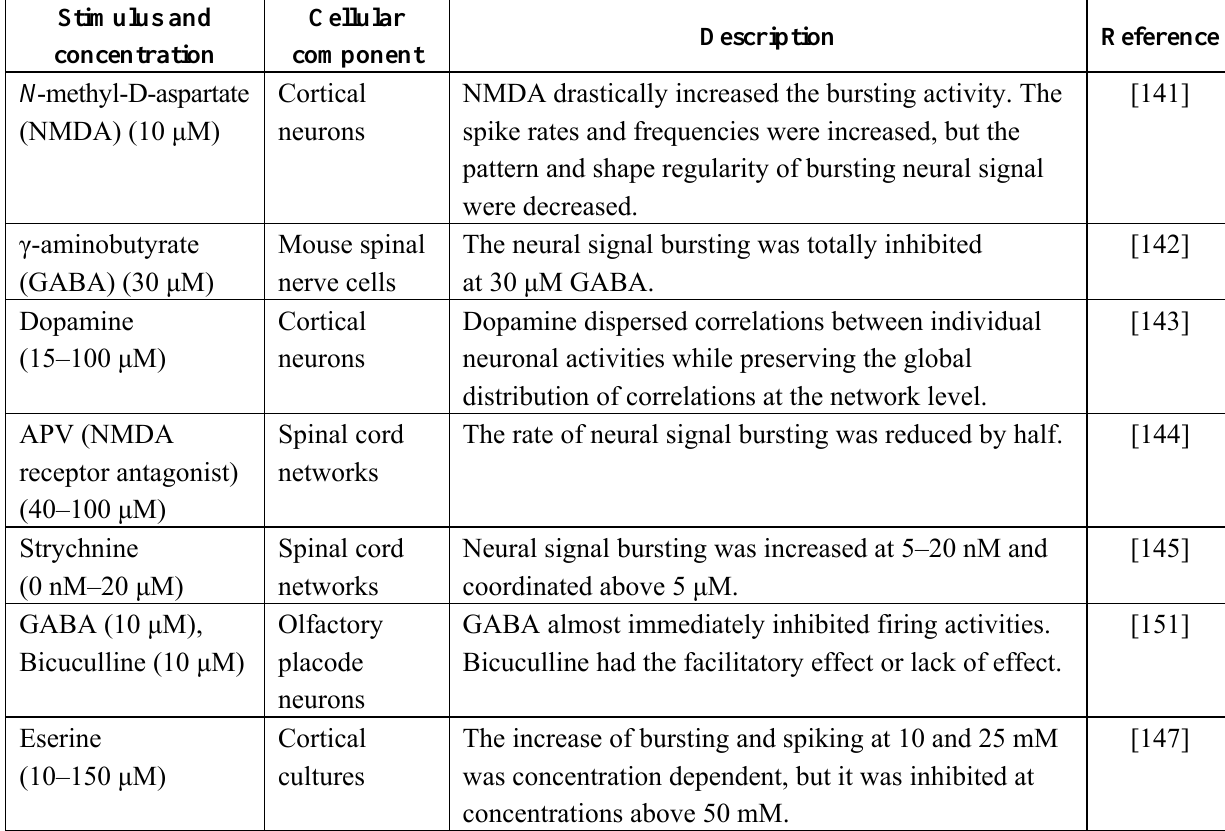
Table 1. The study of pharmacology on neuronal networks based on